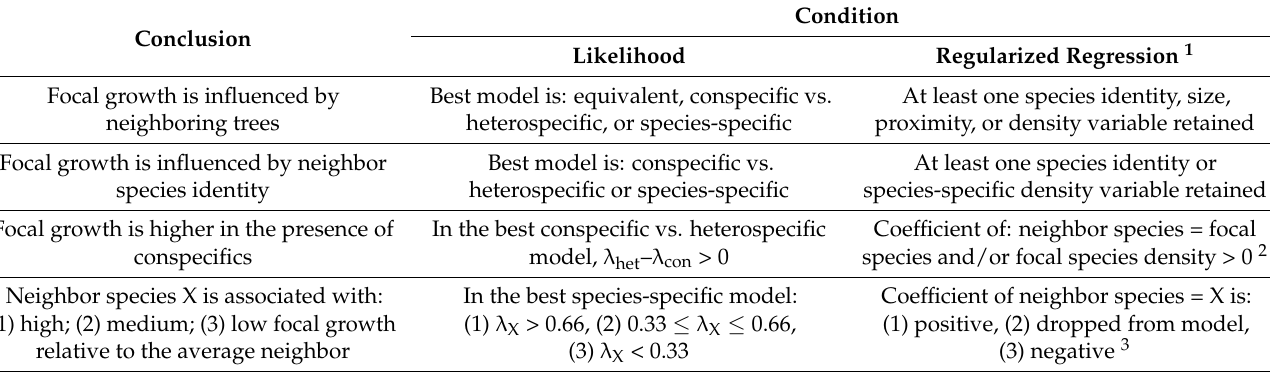
Table 1. Conditions used to draw conclusions regarding inferential questions in the likelihood and regularized regres- sion